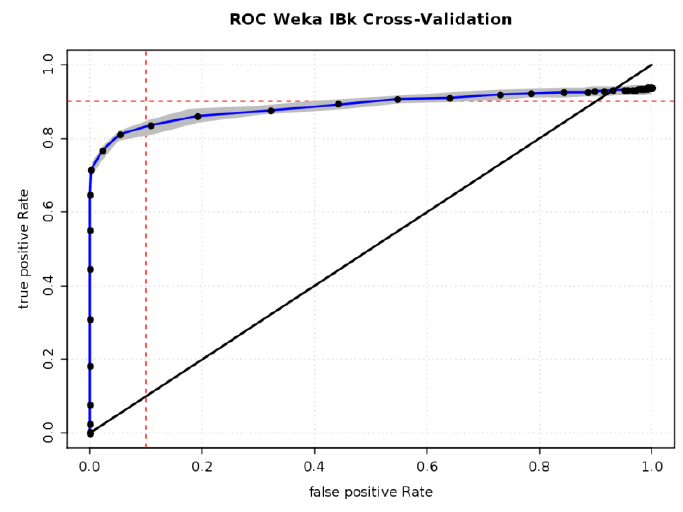
Figure 10. ROC-Curve for KNN classifier.